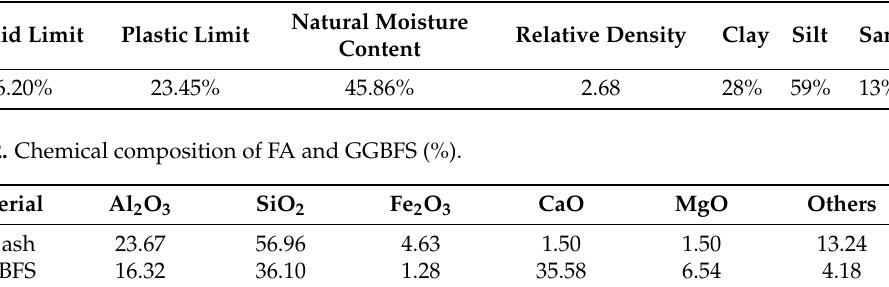
Table 1. Basic physical properties of Hangzhou soil specimens.